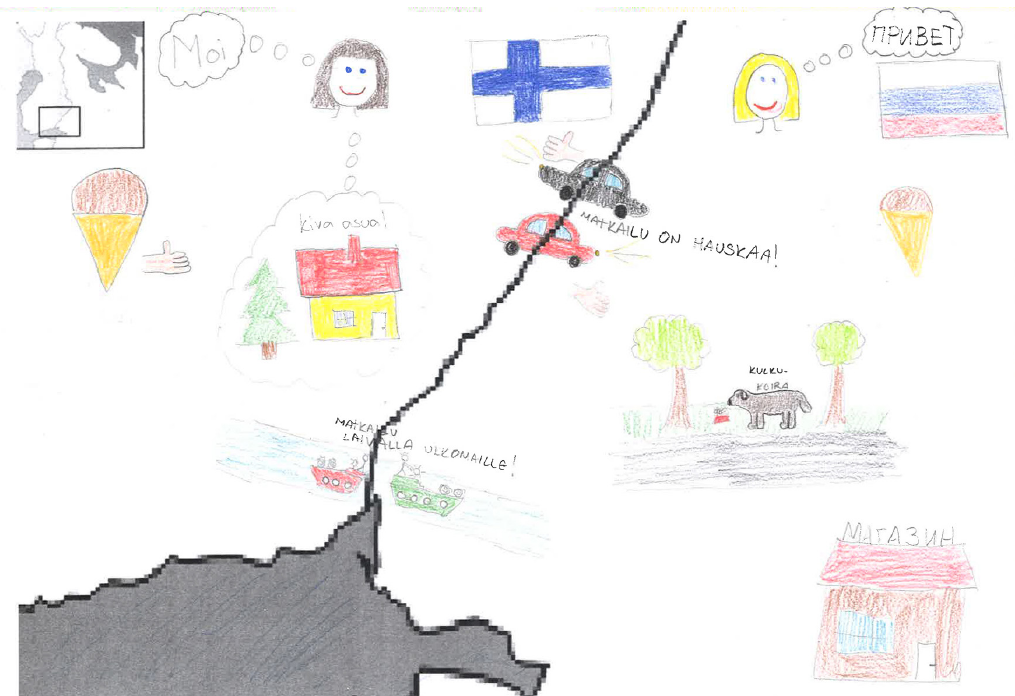
Fig. 2 . A fifth-class Finnish girl from the school specialising in the Russian language draws a very positive image of the borderland and sees the border as a connecting